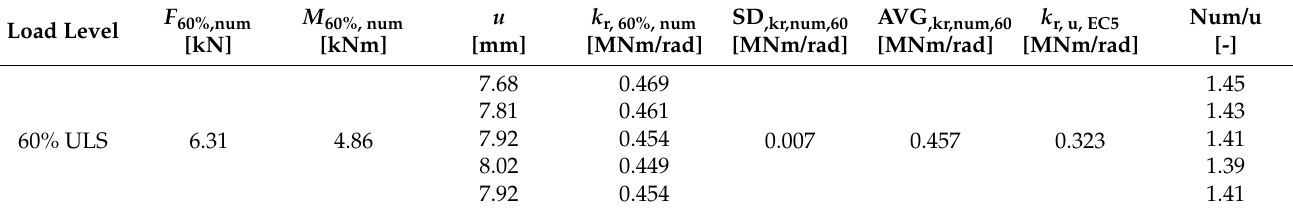
Table 15. Results of quasi-static cyclic numerical modeling for Experiment B at 60% ULS.